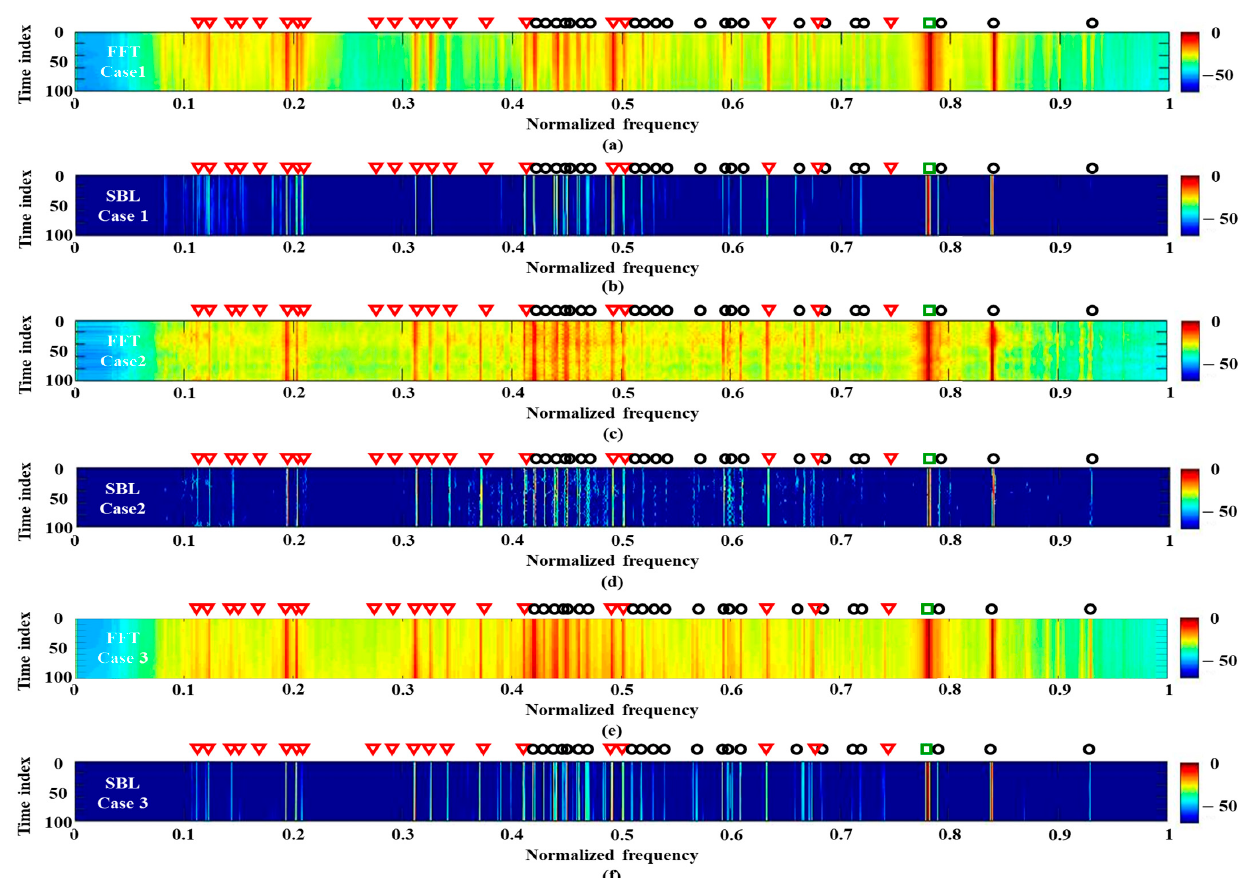
Figure 8. The frequency detection results using multiple measurements which are measured when the experimental ship is farther from the array: ( a ) FFT using multiple measurements over time; ( b ) SBL using multiple measurements over time; ( c ) FFT using multiple measurements across the sensors; ( d ) SBL using multiple measurements across the sensors; ( e ) FFT using multiple measurements along time and sensors; ( f ) SBL using multiple measurements along time and sensors.